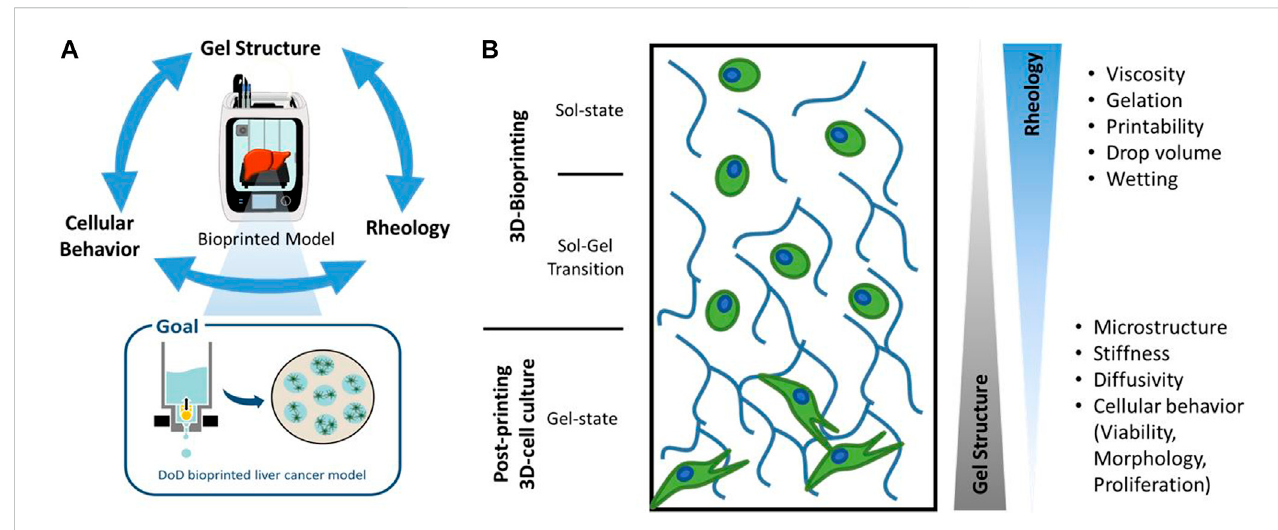
FIGURE 1 Schematic drawing of hydrogel properties and their in fl uence on a Drop-on-Demand (DoD)-bioprinted liver cancer model. Different hydrogel properties dominate during the 3D-bioprinting process and in the subsequent 3D-cell culture, which are characterized in this work.